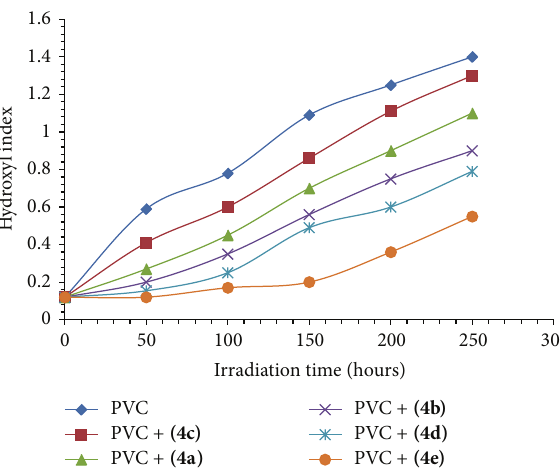
Figure 5: The relationship between the hydroxyl index and irradi- ation time for PVC films (30 𝜇 m thickness) with or without 4a–e (0.5% by weight).